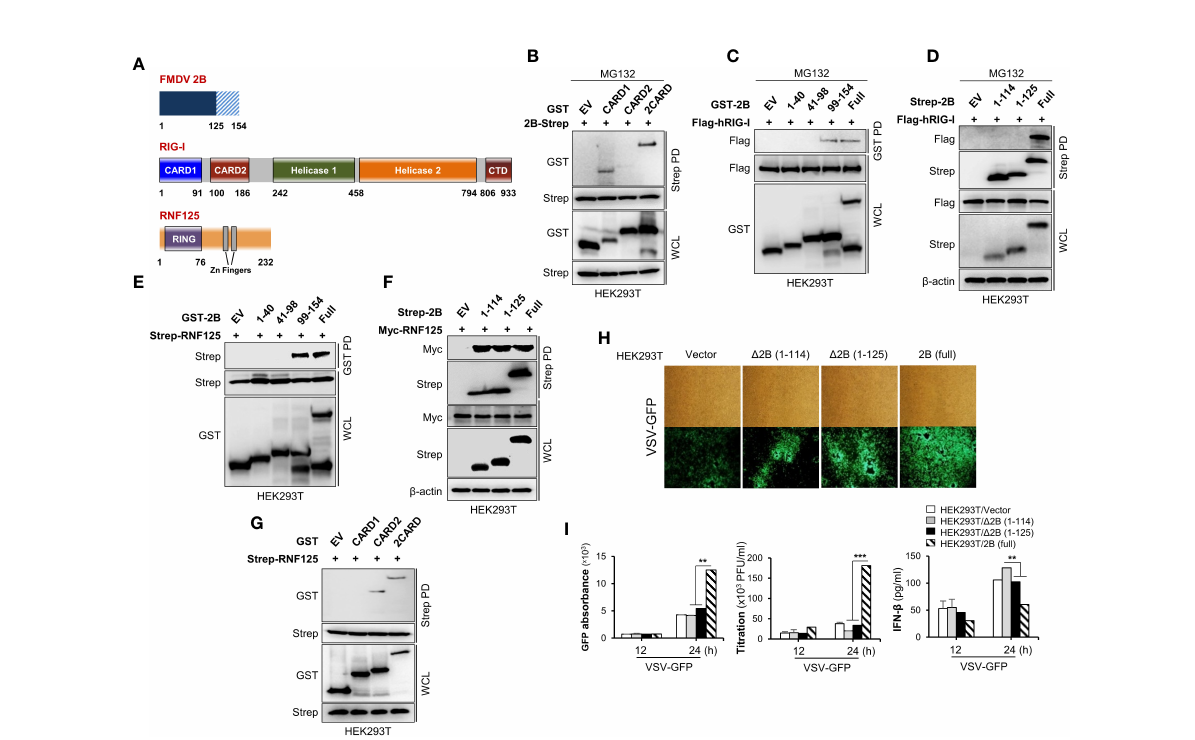
FIGURE 5 C-terminal region of FMDV 2B is important for the interaction and proteasomal degradation of RIG-I. Schematic representation of the domain construction of FMDV 2B, RIG-I, and RNF125 (A) . HEK293T cells were transfected with GST-RIG-I domain constructs together with Strep-FMDV 2B plasmids and treated with MG132 for 6 hours before harvesting the cells. Whole-cell lysates were subjected to the Strep pull-down assay, followed by immunoblotting with indicated antibodies (B) . HEK293T cells were transfected with Flag-RIG-I together with GST-FMDV 2B domain constructs containing plasmids and treated with MG132 for 6 hours before harvesting the cells. Whole-cell lysates were subjected to GST pull- down and immunoblotted with indicated antibodies (C) . HEK293T cells were transfected with Strep-FMDV 2B domain constructs together with Flag-RIG-I plasmids and treated with MG132 for 6 hours before harvesting the cells. Whole-cell lysates were subjected to the Strep pull-down assay, followed by immunoblotting with indicated antibodies (D) . HEK293T cells were transfected with Strep-RNF125 together with GST-FMDV 2B domain constructs containing plasmids. Whole-cell lysates were subjected to GST pull own and immunoblotted with indicated antibodies (E) . HEK293T cells were transfected with Myc-RNF125 together with Strep-FMDV 2B deletion mutant constructs containing plasmids. Whole- cell lysates were subjected to Strep pull own and immunoblotted with indicated antibodies (F) . HEK293T cells were transfected with Strep- RNF125 together with GST-RIG-I domain constructs containing plasmids. Whole-cell lysates were subjected to strep pull down and immunoblotted with indicated antibodies (G) . (H, I) HEK293T cells were transfected with control vector, FMDV D 2B (1-114) mutant, FMDV D 2B (1-125) mutant, and FMDV 2B wild-type plasmids and infected with VSV-GFP. Viral replication was measured by fl uorescence microscopy, GFP absorbance, and plaque assay at indicated time points. The concentration of secreted IFN- b in supernatants was determined at 12 and 24 hpi by ELISA. Results representative of at least two independent experiments, each with similar results, and the values are expressed as mean ± SD of three biological replicates. Student ’ s t-test; **p < 0.01; ***p <